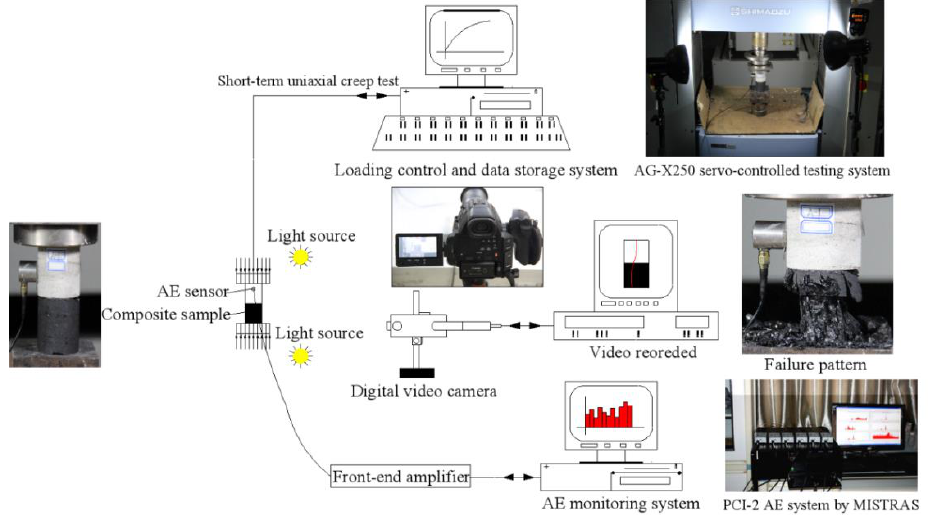
Figure 3. Testing system for short-term uniaxial creep on sandstone-coal composite samples (revised from Yin et al. [20]).